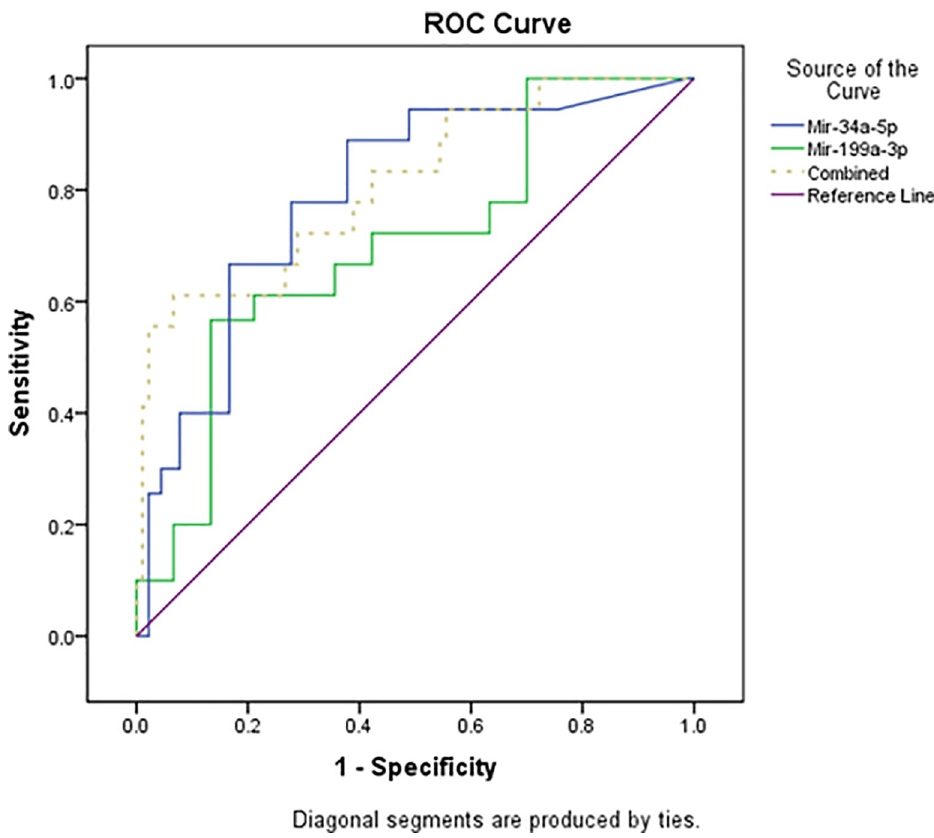
Fig 2. ROC curve analysis of serum miR-34a-5p and miR-199a-3p for differentiating neonates with sepsis from healthy ones.